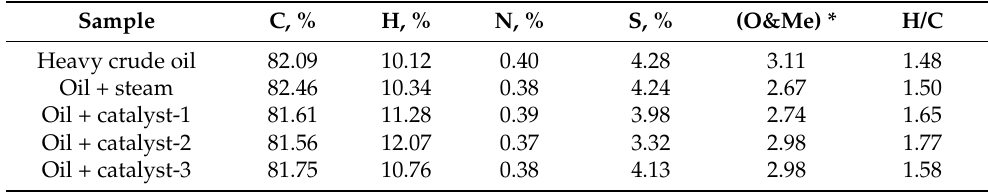
Table 5. Elemental Analysis of heavy crude oil and upgraded oil samples.